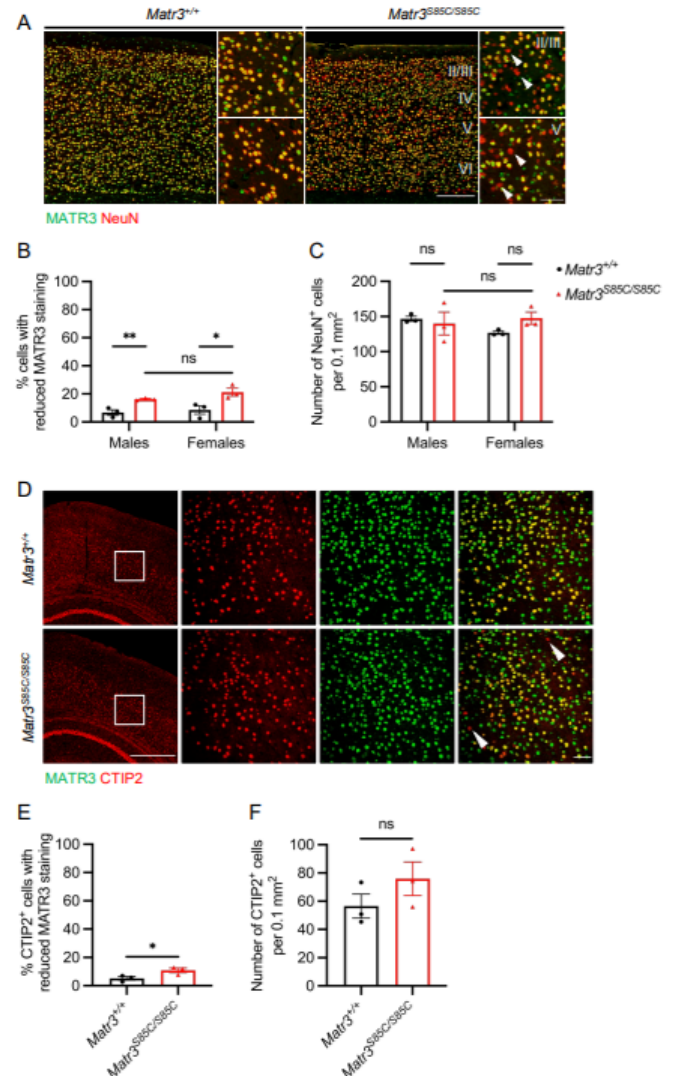
Figure 3. MATR3 loss in upper motor neurons and cortical neurons in Matr3 S85C/S85C mice. ( A ) Representative images of the cortex with Roman numerals denoting the cortical layers. The scale bar for the full cortex images denotes 250 µ m and the zoomed-in images denotes 50 µ m. Ar- rowheads denote cells with reduced MATR3 staining. Brain sections are from 60-week-old mice. ( B ) Quantification of the number of NeuN + cells with reduced MATR3 staining (males: n = 3 Matr3 +/+ , 3 Matr3 S85C/S85C ; females: n = 3 Matr3 +/+ , 3 Matr3 S85C/S85C ). ( C ) Quantification of the number of NeuN + cells (males: n = 3 Matr3 +/+ , 3 Matr3 S85C/S85C ; females: n = 3 Matr3 +/+ , 3 Matr3 S85C/S85C ). ( D ) Representative images of the cortex stained with CTIP2 with scale bar denoting 500 µ m (images on the left column). Representative enlarged images of the cortical layer V with the scale bar denoting 50 µ m (images on the right three columns). Arrowheads denote cells with reduced MATR3 staining. Brain sections are from 30-week-old mice. ( E ) Quantification of the number of CTIP2 + cells with reduced MATR3 staining ( n = 3 Matr3 +/+ , 3 Matr3 S85C/S85C ). ( F ) Quantification of the number of CTIP2 + cells ( n = 3 Matr3 +/+ , 3 Matr3 S85C/S85C ). Bar graph heights depict mean ± SEM, with each datapoint representing an animal. * p < 0.05, ** p < 0.01, ns = not